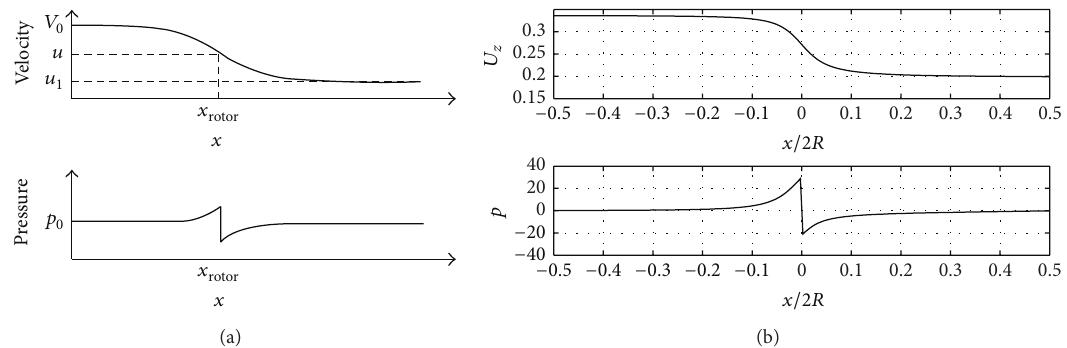
Figure 4: Pressure and velocity profiles along the centre line given by (a) the 1D momentum theory [10] and (b) the developed model.